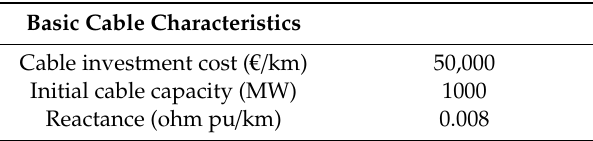
Table 2. Characteristics of transmission lines /